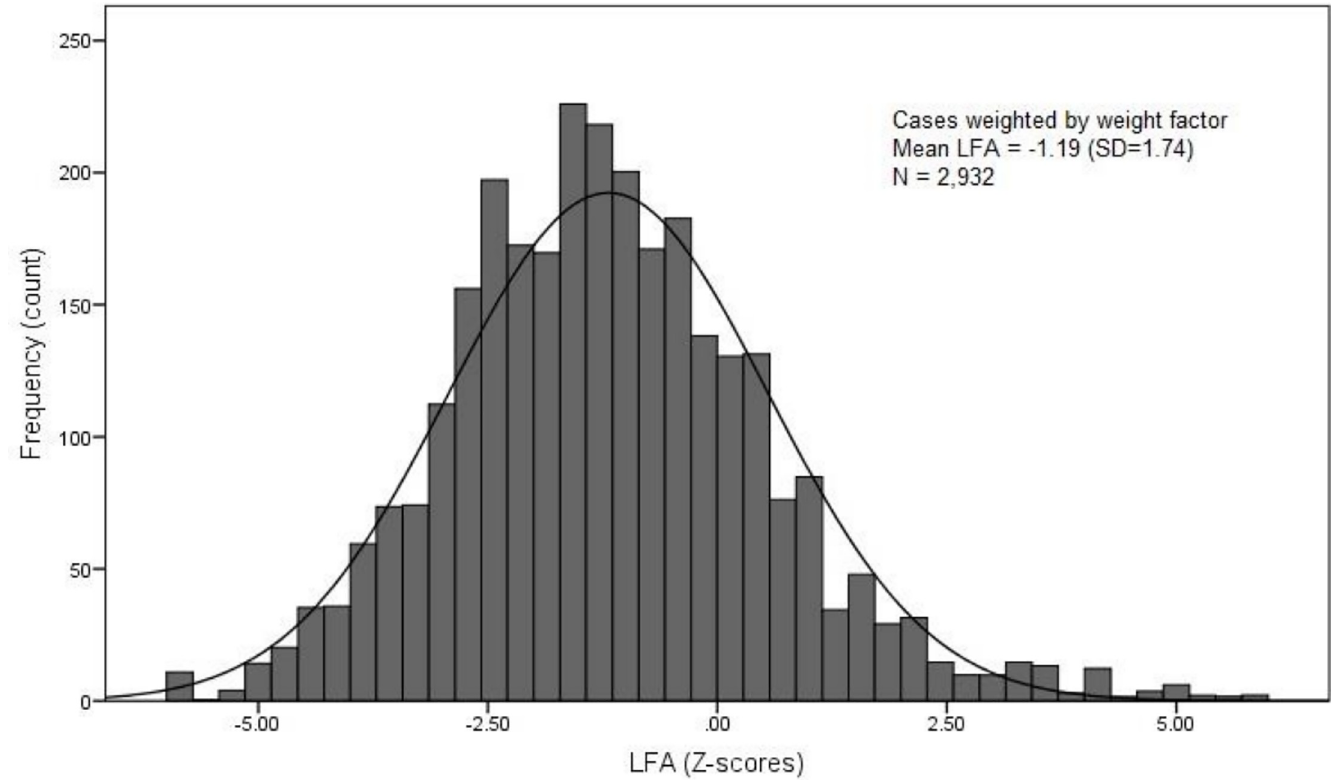
Fig 2. Length-for-age distribution of study participants (N =